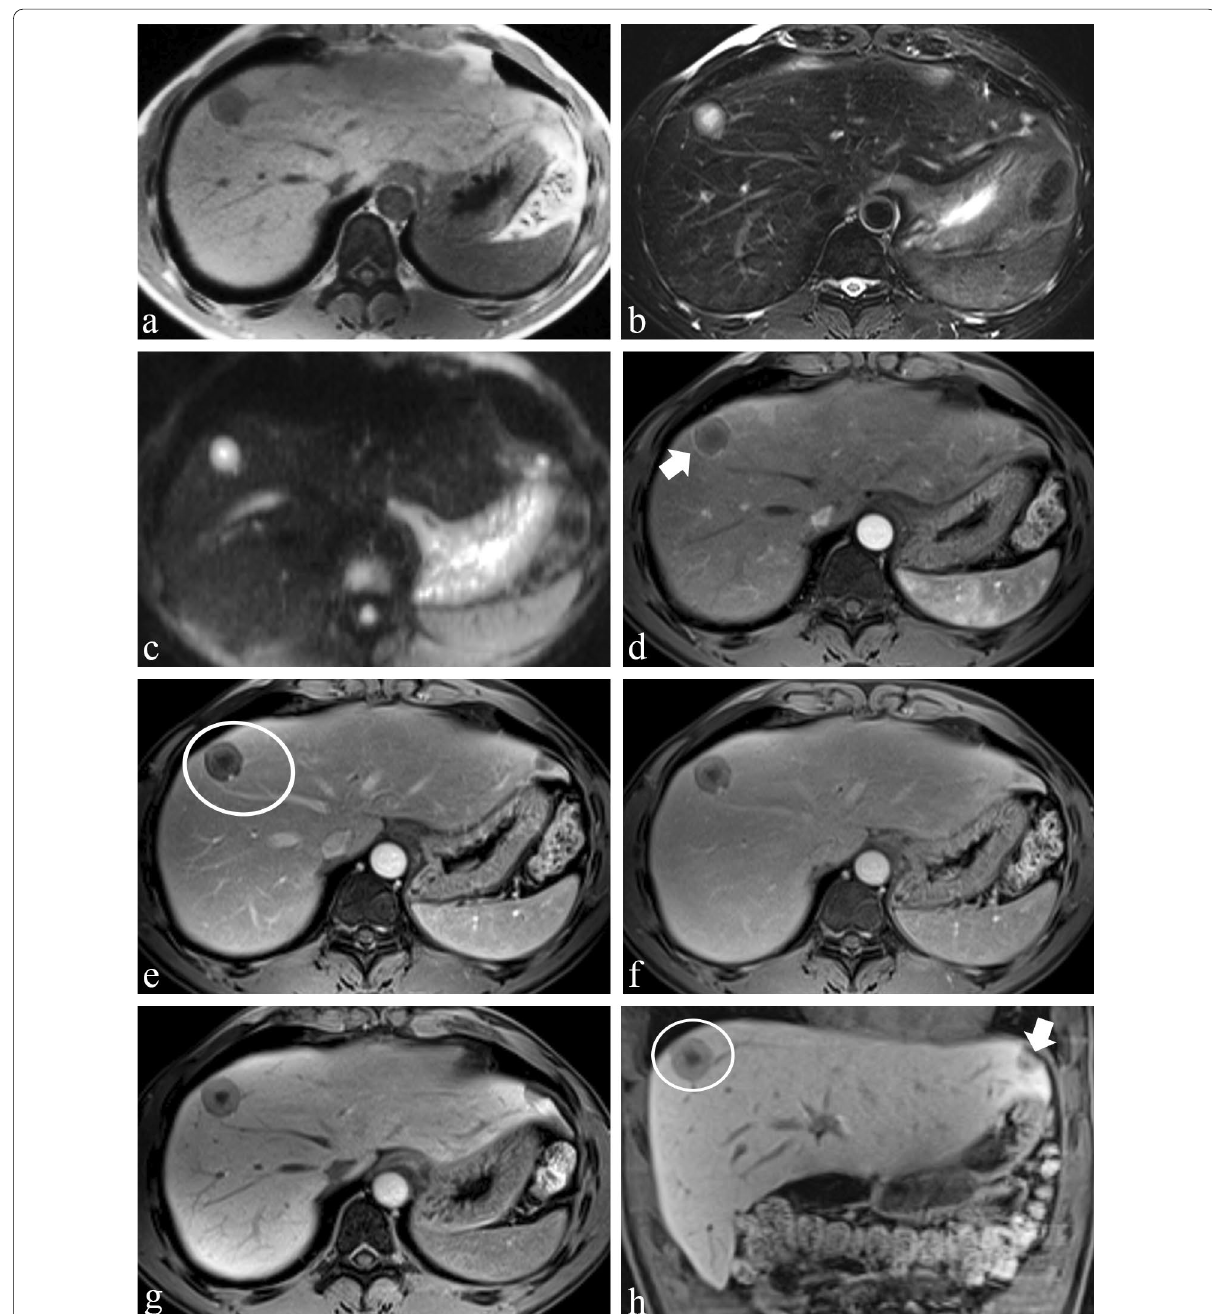
Fig. 3 A 42-year-old male with pathologically confirmed HEHE, which was initially diagnosed as metastases. a Axial T1WI illustrates a hypointense tumour in segment 8 of the liver; b , c the “target sign” was composed of slight peripheral hyperintensity and bright central hyperintensity on axial T2WI and DWI. d – h Contrast-enhanced MRI after administration of gadoxetic acid shows enhancement pattern A of the tumour. d The axial arterial phase shows a peripheral thin ring enhancement ( arrow ); the nodule showed the typical “target sign” on all phases after enhancement ( circle, h ), and the “lollipop sign” on the portal venous phase ( circle, e ). There was another lesion with hepatic capsular retraction ( arrow ) on the coronal HBP ( h